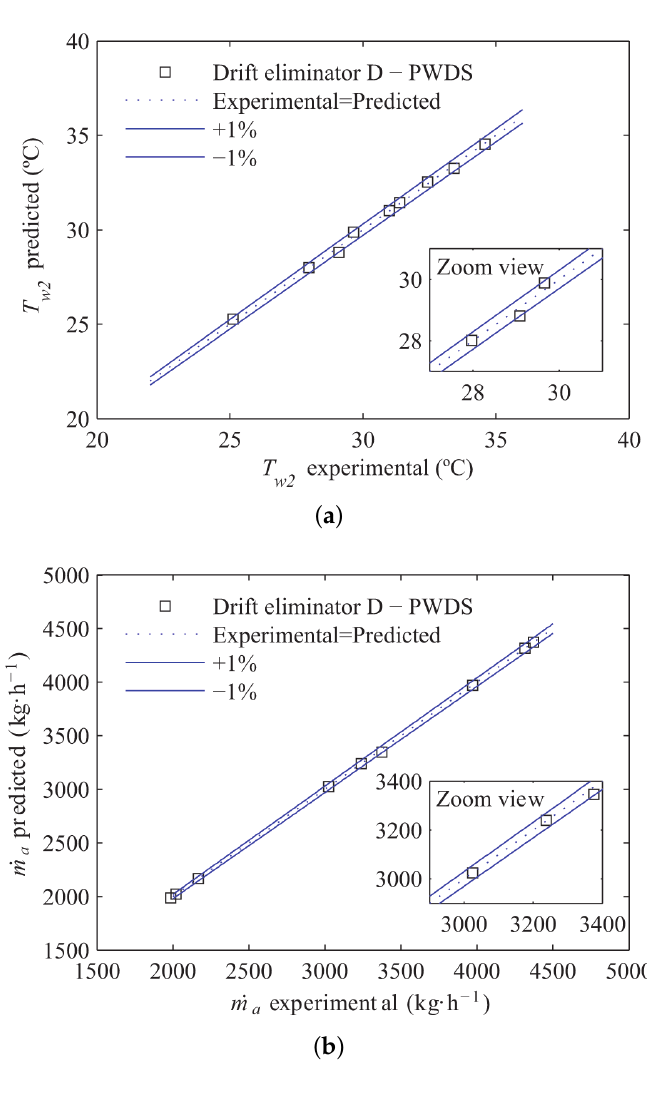
Figure 5. Cooling tower validation configured with PWDS system and Drift Eliminator D, regarding water outlet temperature ( a ) and air mass flow rate ( b ).